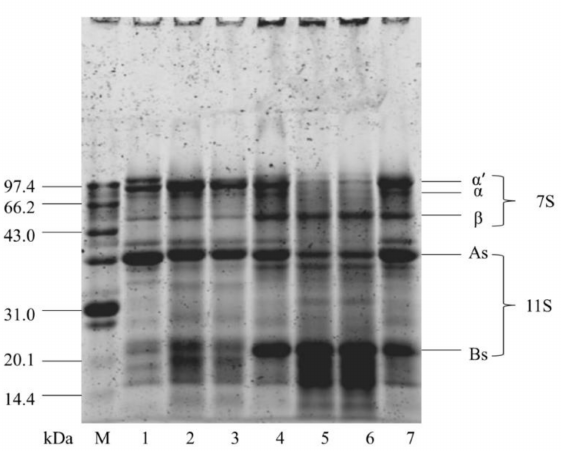
Figure 4. SDS-PAGE patterns of oxidized SPI before and after cavitation jet treatment. Band 1–7: B, C, D, E, F, G, and A. M: